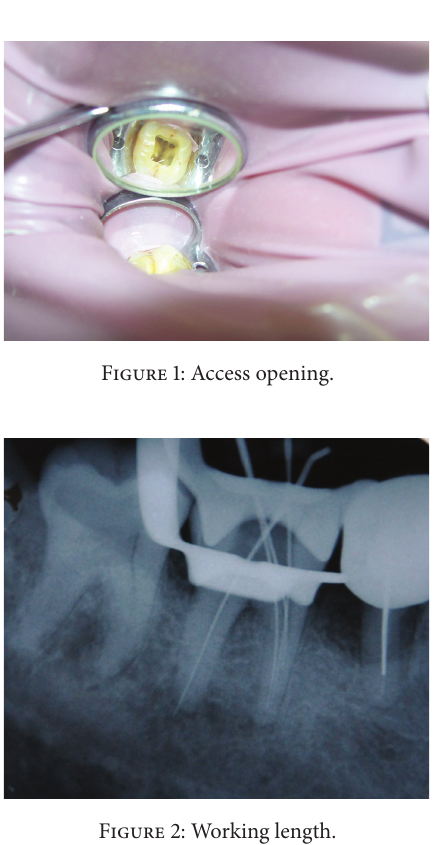
Figure 2: Working length.